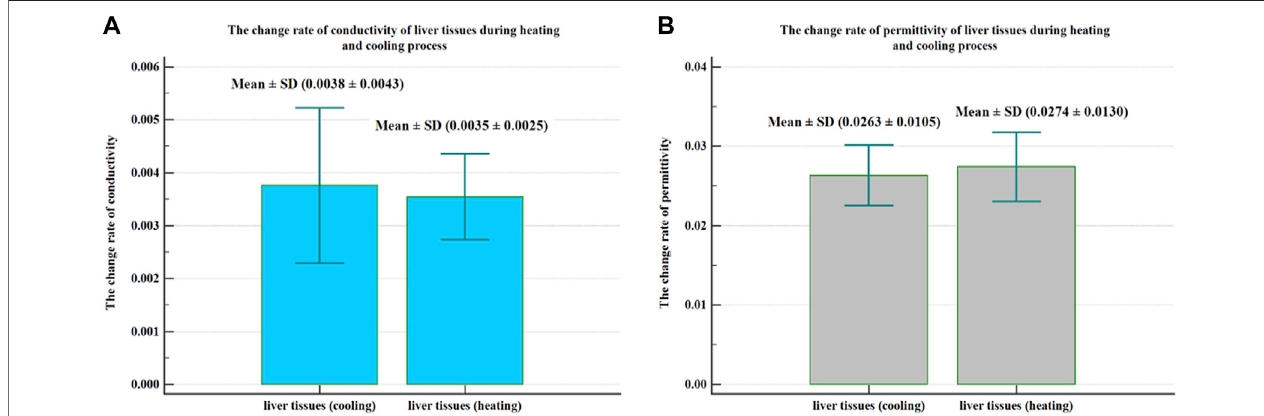
FIGURE 7 | The change rate of conductivity and permittivity of liver tissues during the heating and cooling process. During the heating and cooling process of liver tissues, the change rate of conductivity per degree was 0.0035 ± 0.0025 and 0.0038 ± 0.0043, respectively (A) , and the change rate of permittivity per degree was